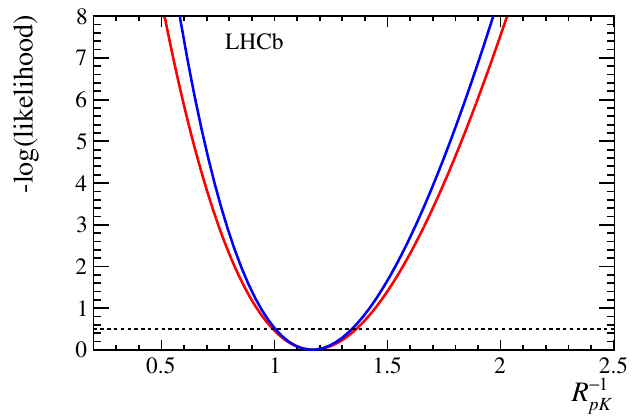
Figure 4. Logarithm of the pro(cid:12)le likelihood of the R (cid:0) 1 statistical (total) uncertainty. The dashed line indicates the one standard deviation